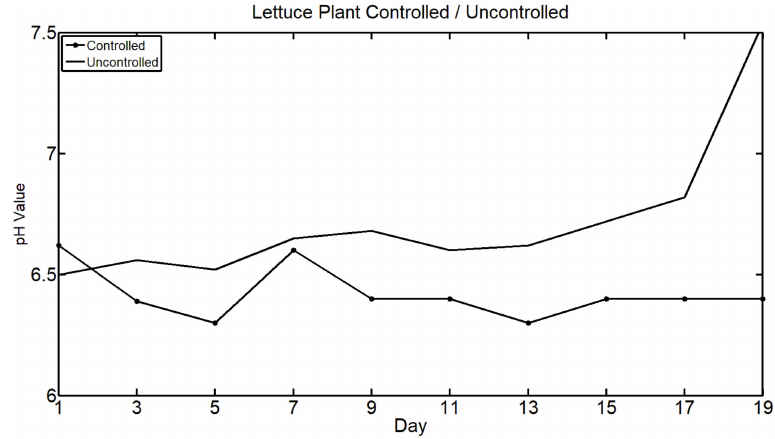
Figure 10. Comparison of lettuce pH values over 19